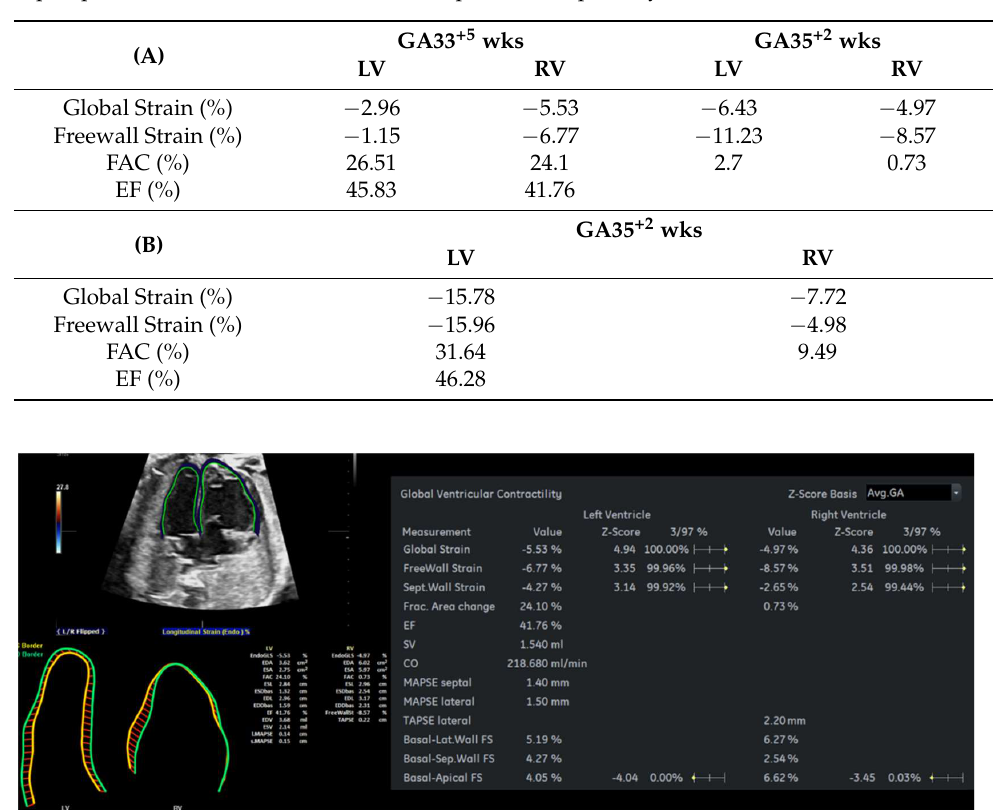
Figure 5. Fetal HQ results of the fetus with CVD using the speckle-tracking technique at a GA 35 +2 wks. CO, cardiac output; EdoGLS, endocardium global strain; EDA, end-diastolic area; EDS, end- systolic area; EF, ejection fraction; ESL, end-systolic length; ESDbas, end-systolic displacement of basal; FAC, fractional area change; GA, gestational age; Lat, lateral; LV, left ventricle; MAPSE, mitral annular plane systolic excursion; RV, right ventricle; Sep, septal; SV, stroke volume; TAPSE, tricuspid annular plane systolic excursion; wks; weeks.